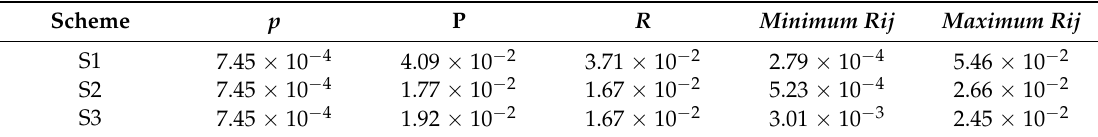
Table 4. Risk assessment of S1, S2, and S3.